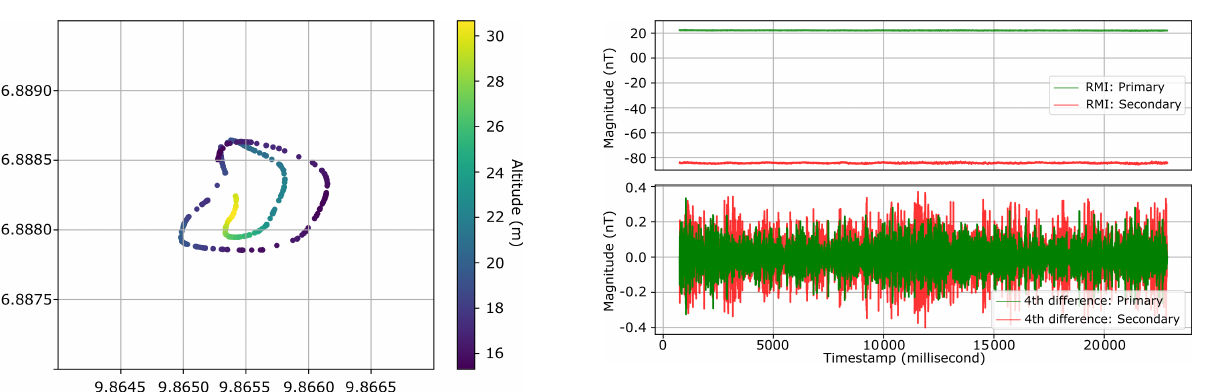
Figure 11. Data excerpt of RMI profiles recorded by the primary and secondary magnetometer and their respective fourth difference while the UAV was on standby with d = 20cm and L = 30cm on 5 March 2020. The IGRF (50563nT) has been